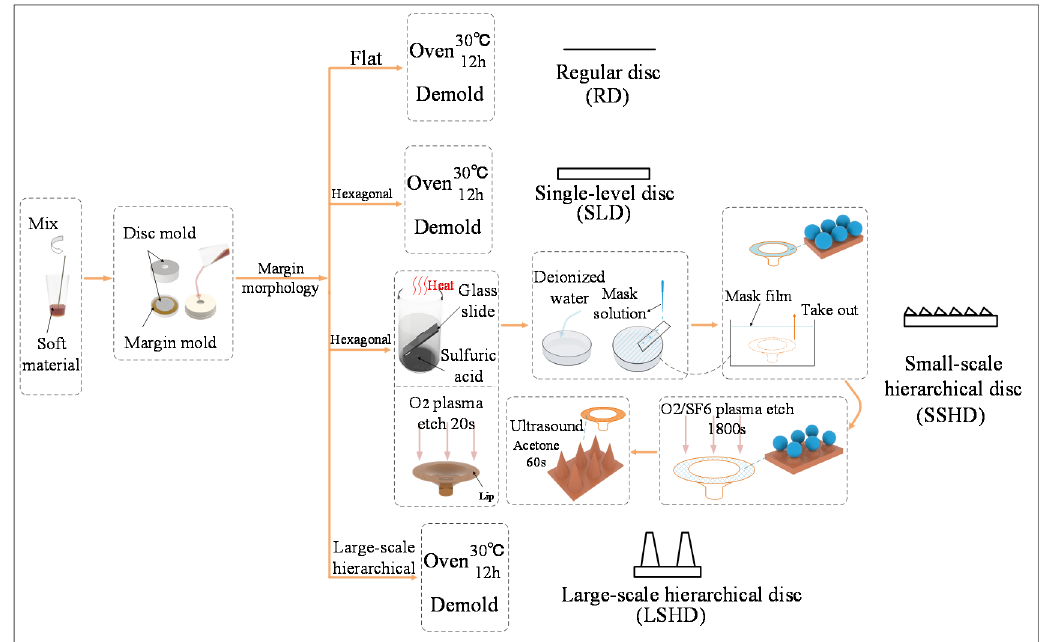
Figure 3. Manufacturing process of the microstructure.